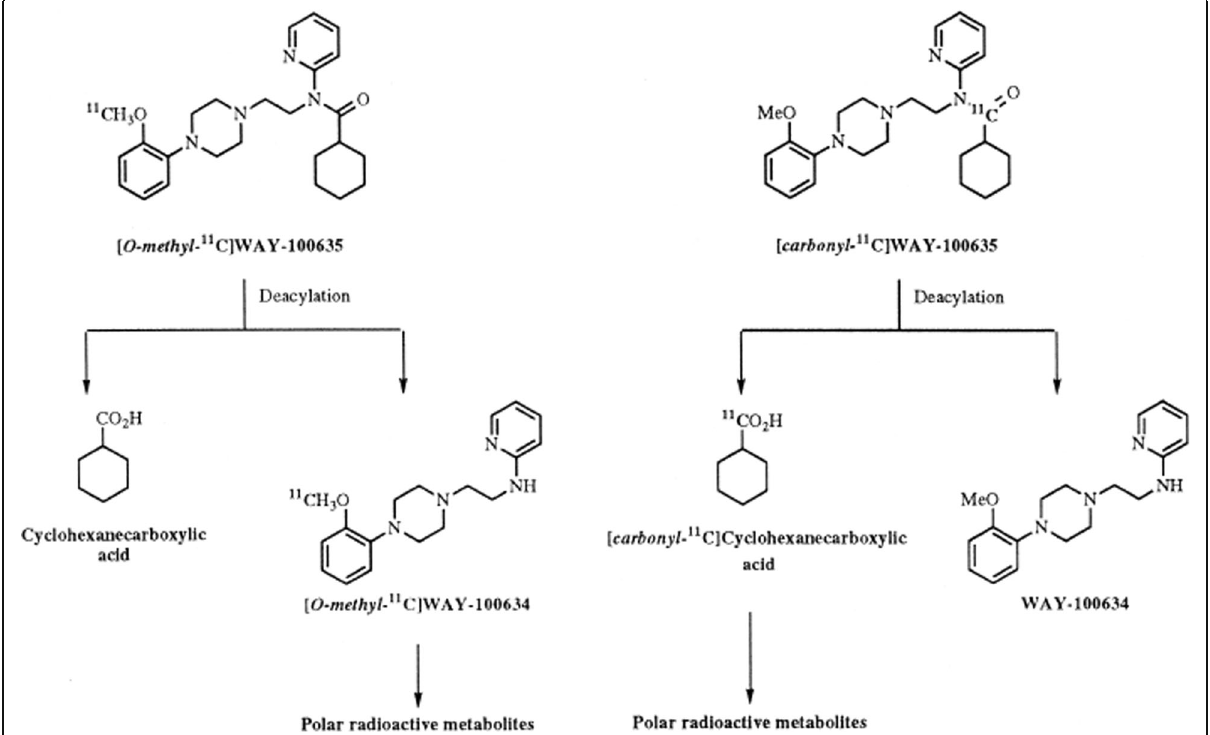
Fig. 11 Pathways deduced for the metabolism of [O-methyl- 11 C]WAY-100635 and [carbonyl- 11 C]WAY-100635 in cynomolgus monkeys and humans. Adapted with permission from Ref. [23]